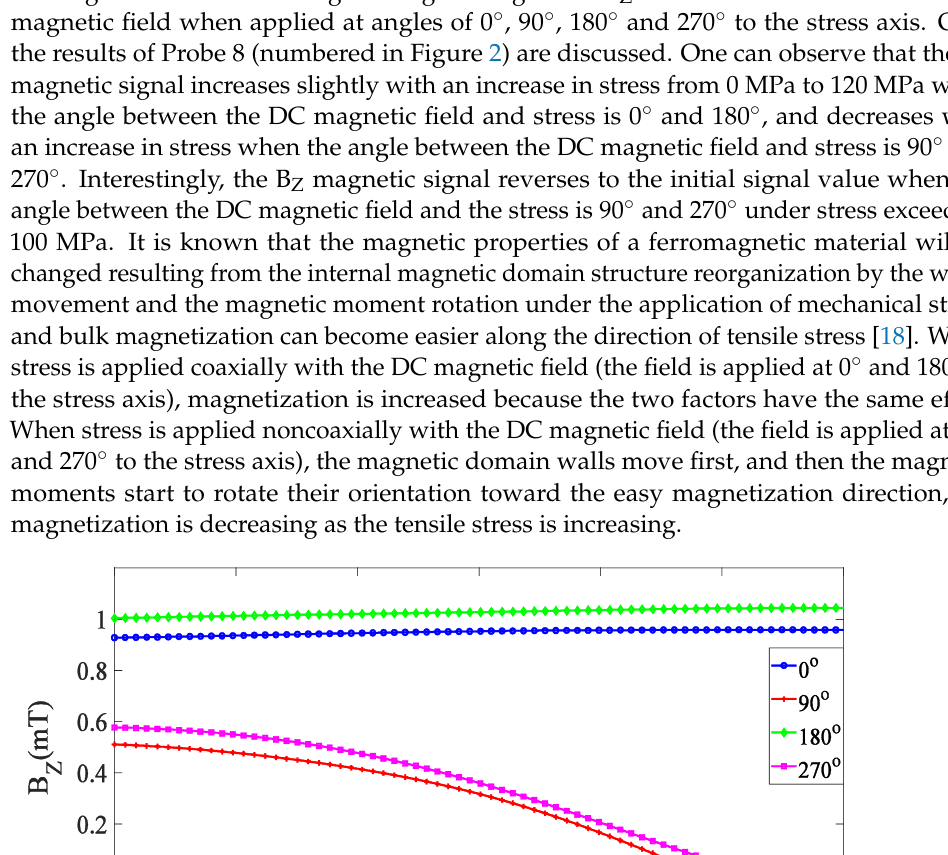
Figure 6. Distribution of the magnetic flux and magnetic pole of the measured area when the angle between the DC magnetic field and stress is: ( a ) 0°; ( b ) 90°; ( c ) 180° ; ( d ) 270°.